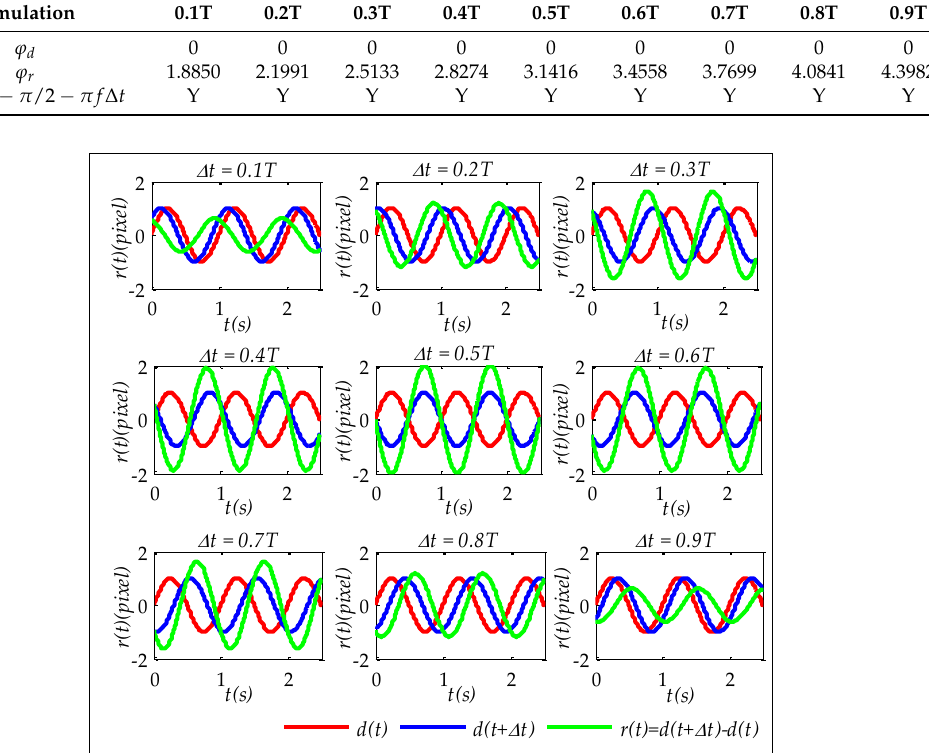
Figure 2. The simulated jitter displacement curves and registration error curves at different imaging time intervals.